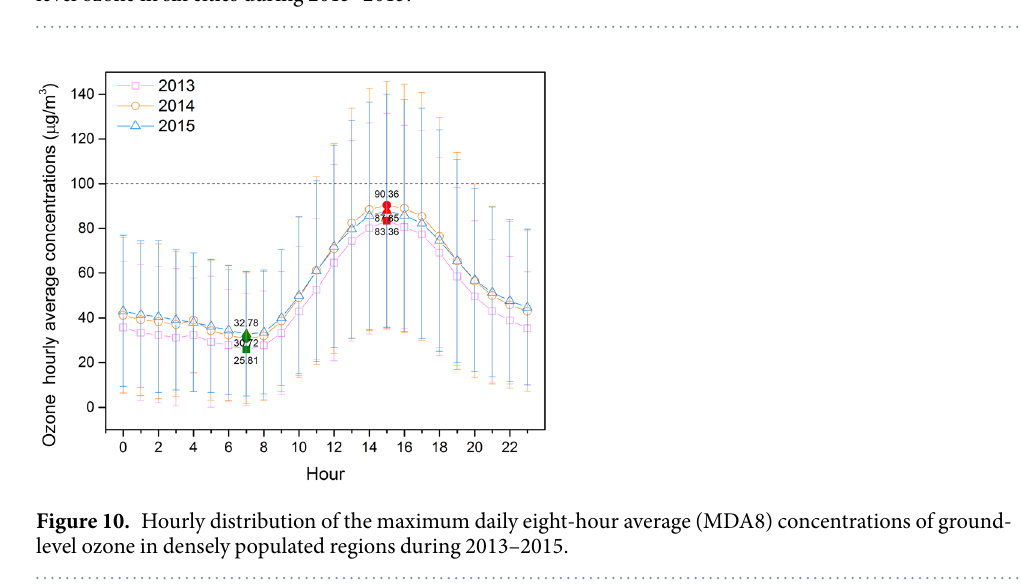
Figure 9. Monthly distribution of the maximum daily eight-hour average (MDA8) concentrations of ground- level ozone in six cities during 2013–2015.